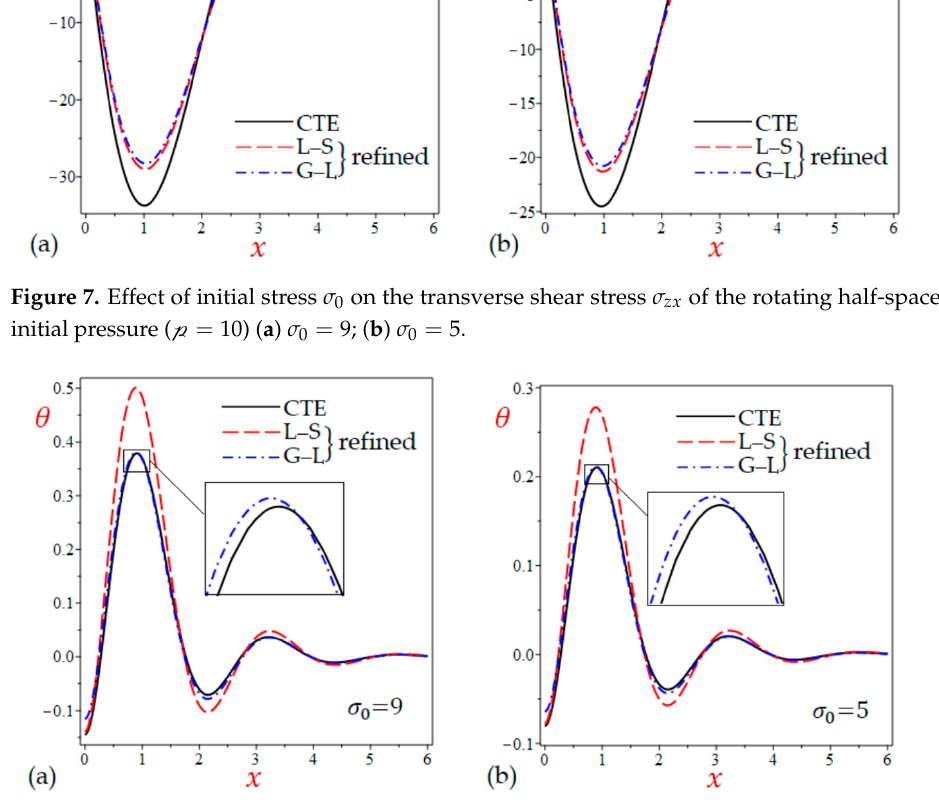
Figure 8. Effect of initial stress σ 0 on the temperature θ of the rotating half-space without initial